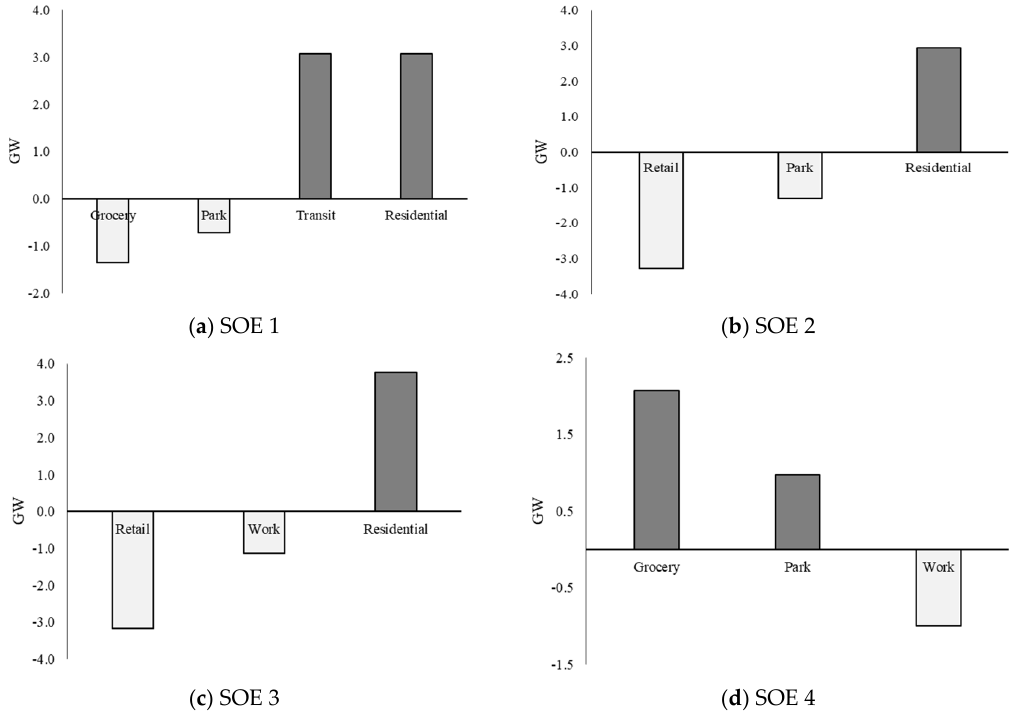
Figure 4. Short-term effects of human-mobility change on electricity